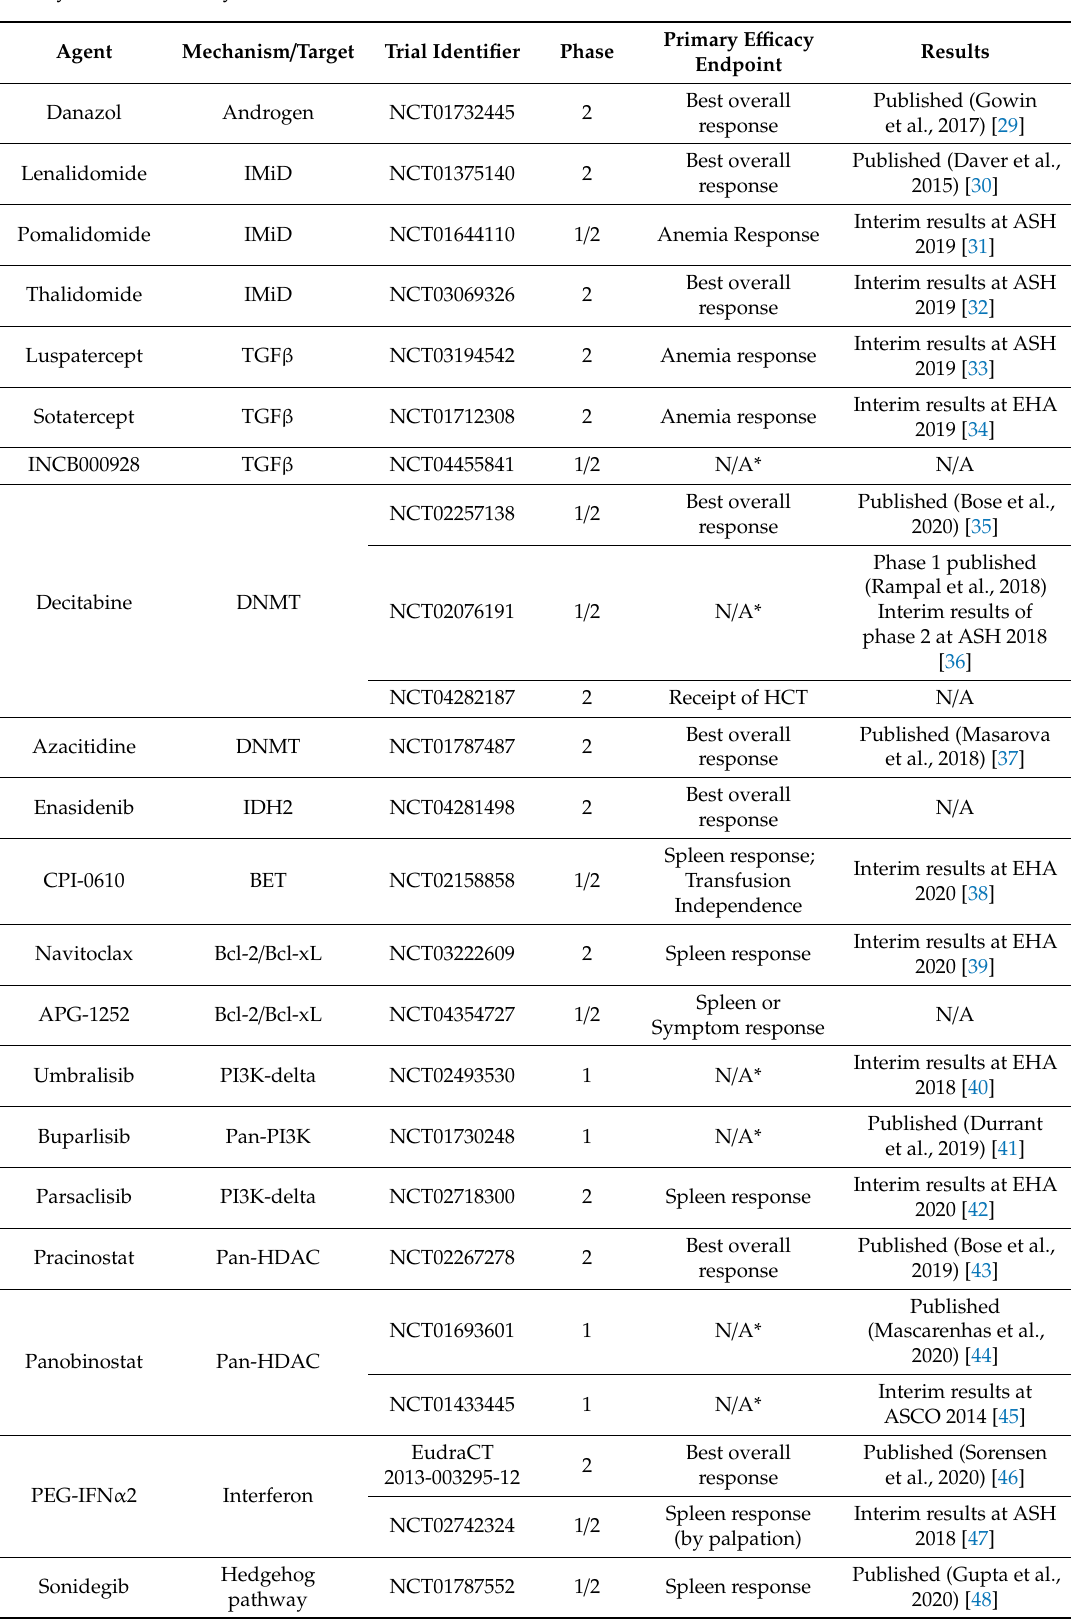
Table 1. Clinical trials assessing ruxolitinib in combination with another agent in patients with myelofibrosis or myelofibrosis-related